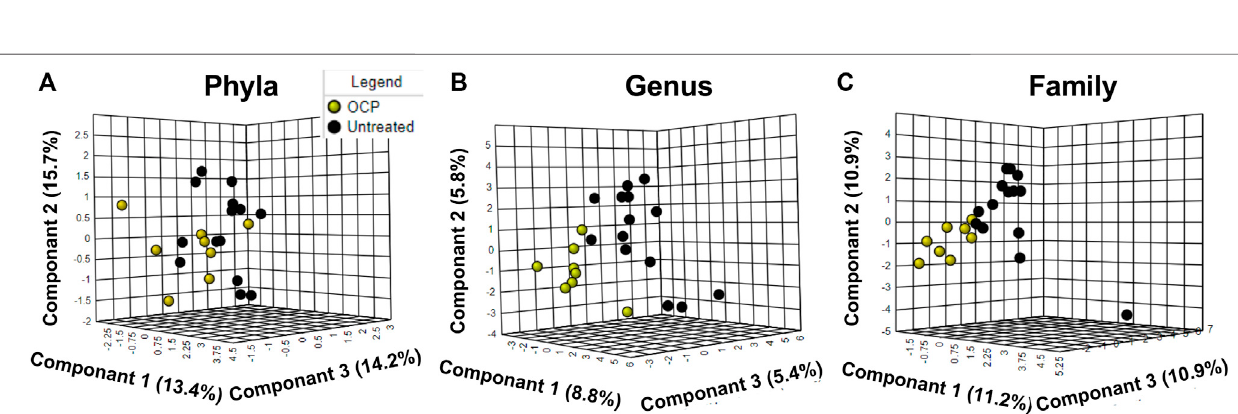
FIGURE1| Bacterial α -Diversity.Measuresof α -biodiversityincluding: (A) Richness(Chao1) (B) Evenness(ShannonH/Hmax), (C) ShannonDiversity(ShannonH). Therewerenostatisticaldifferencesin α -diversitybetweengroups.Shannondiversity,Shannonevenness,andrichness(Sobs)(measuresof α -diversity)werecalculated using rarefaction and compared across groups using linear models adjusting for batch effects. Girls with obesity and PCOS with (N = 8) and without (N = 14) oral contraceptive treatment were included.